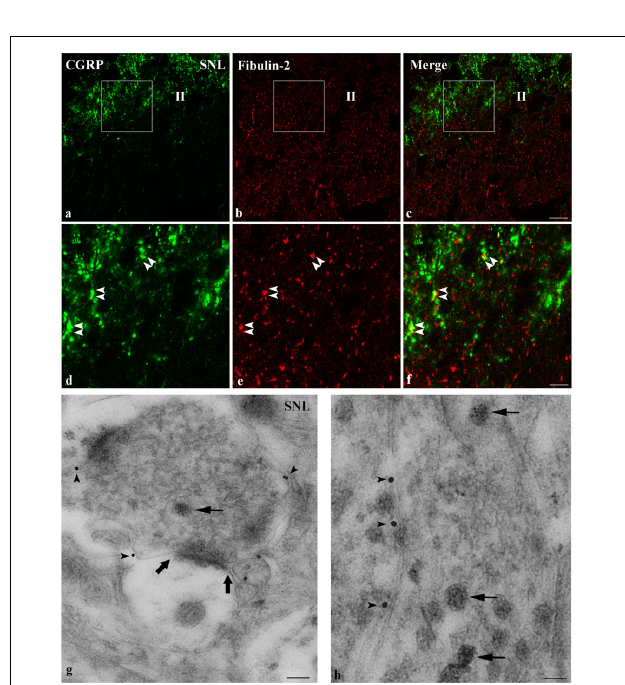
FIGURE 7 | Endogenous co-expression of fibulin-2 and CGRP in neuropathic rats. (a–f) Immunohistochemistry for endogenous fibulin-2 and CGRP in lamina II of the dorsal horn of neuropathic (a–f) rats. Framed areas of the lamina II (II) in a to c are displayed at higher magnification in (d–f) , respectively. CGRP (green) and fibulin-2 (red) staining was frequently seen overlapping or in close apposition (double arrowheads). Bar = 15 µ m (same for all). (g,h) Double immunogold labeling for fibulin-2 (15 nm colloidal gold diameter) and CGRP (5 nm colloidal gold diameter) in the ipsilateral dorsal horn of neuropathic rats. CGRP was found in secretory granules ( d,e , arrows). Secretory granules-containing processes were surrounded by fibulin-2 labeling, at the plasma membrane ( d,e , arrowheads), mostly at extra-synaptic sites (large arrows in d ). Bar = 100 nm in (d) ; 50 nm in (e) .